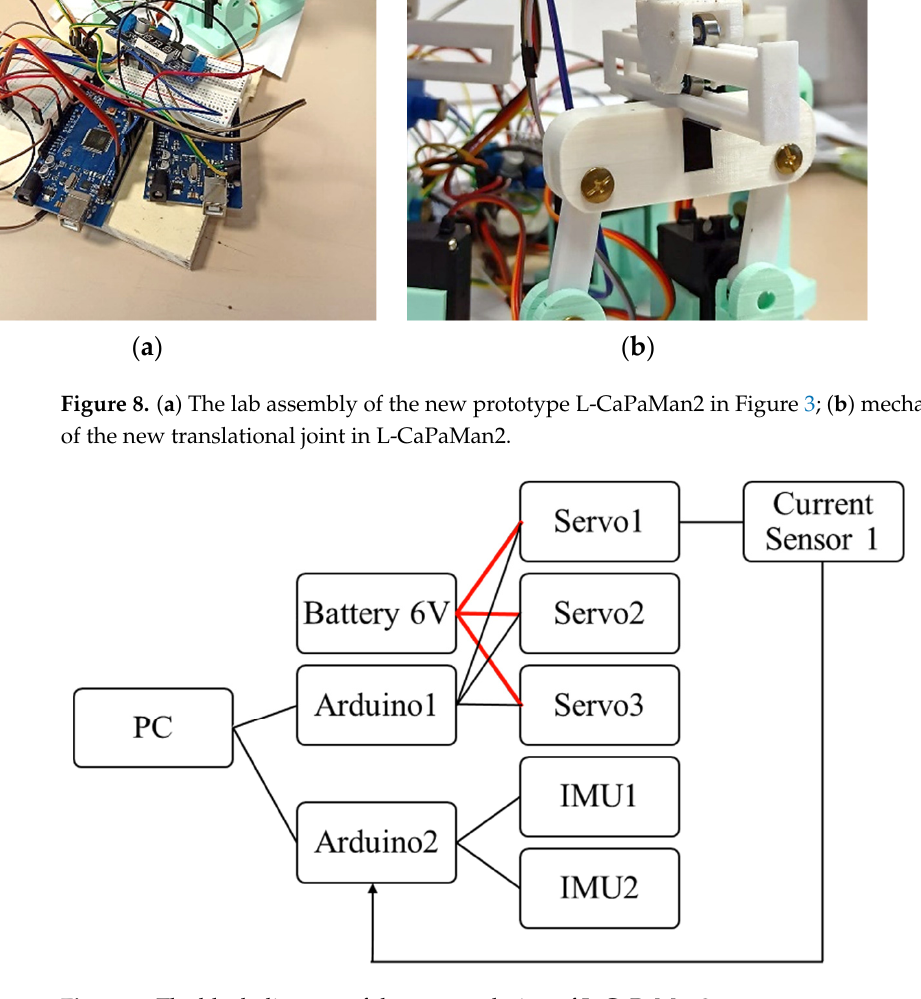
Figure 9. The block diagram of the system design of L-CaPaMan2 prototype. Table 4. Parameters of 3D printing for prototype construction.